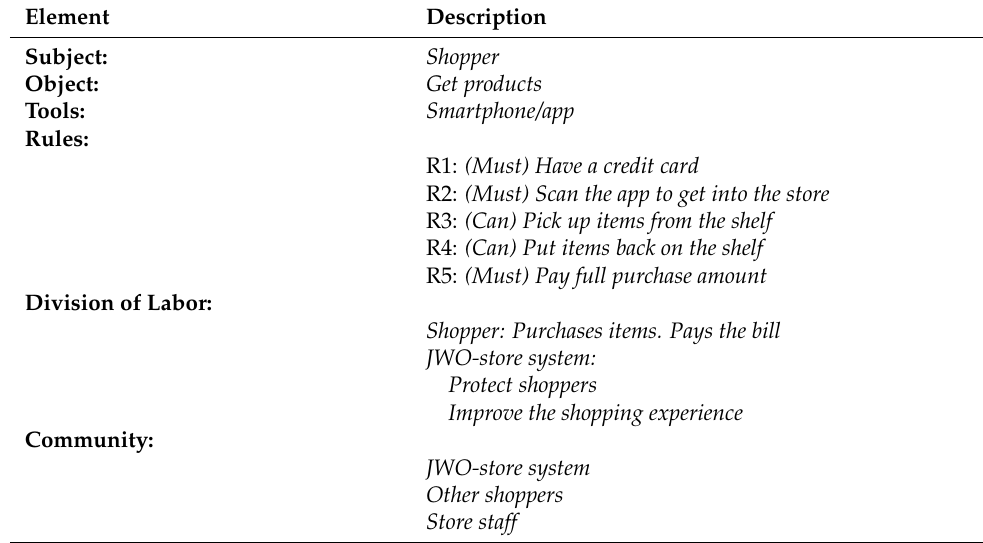
Table 1. Key Activity System for the Shopper.